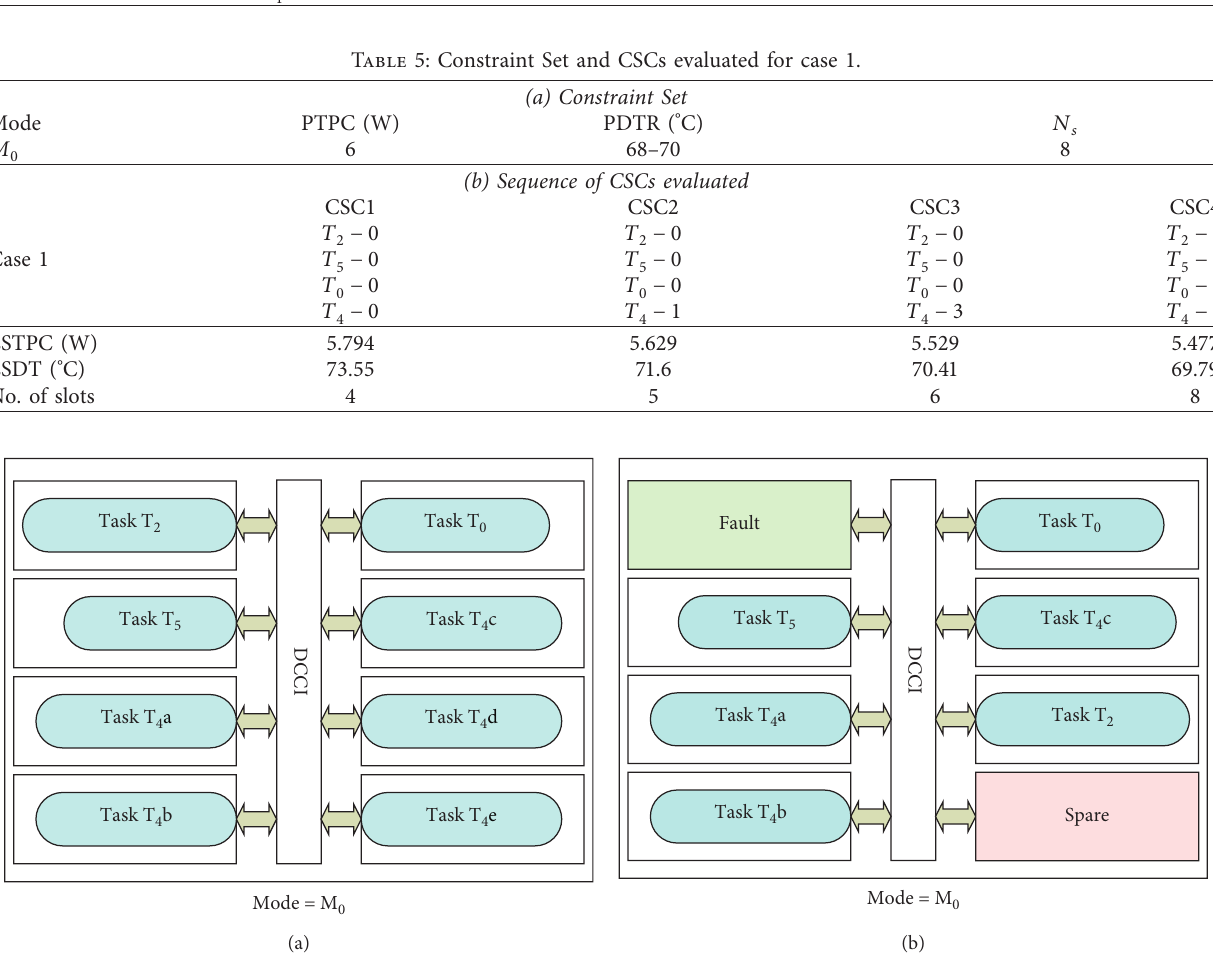
Figure 13: RTSA using Explorer for cases 1 and 2. (a) Selected system configuration for case 1. (b) Selected system configuration for case 2. Table 6: Constraint Set and CSCs evaluated for case